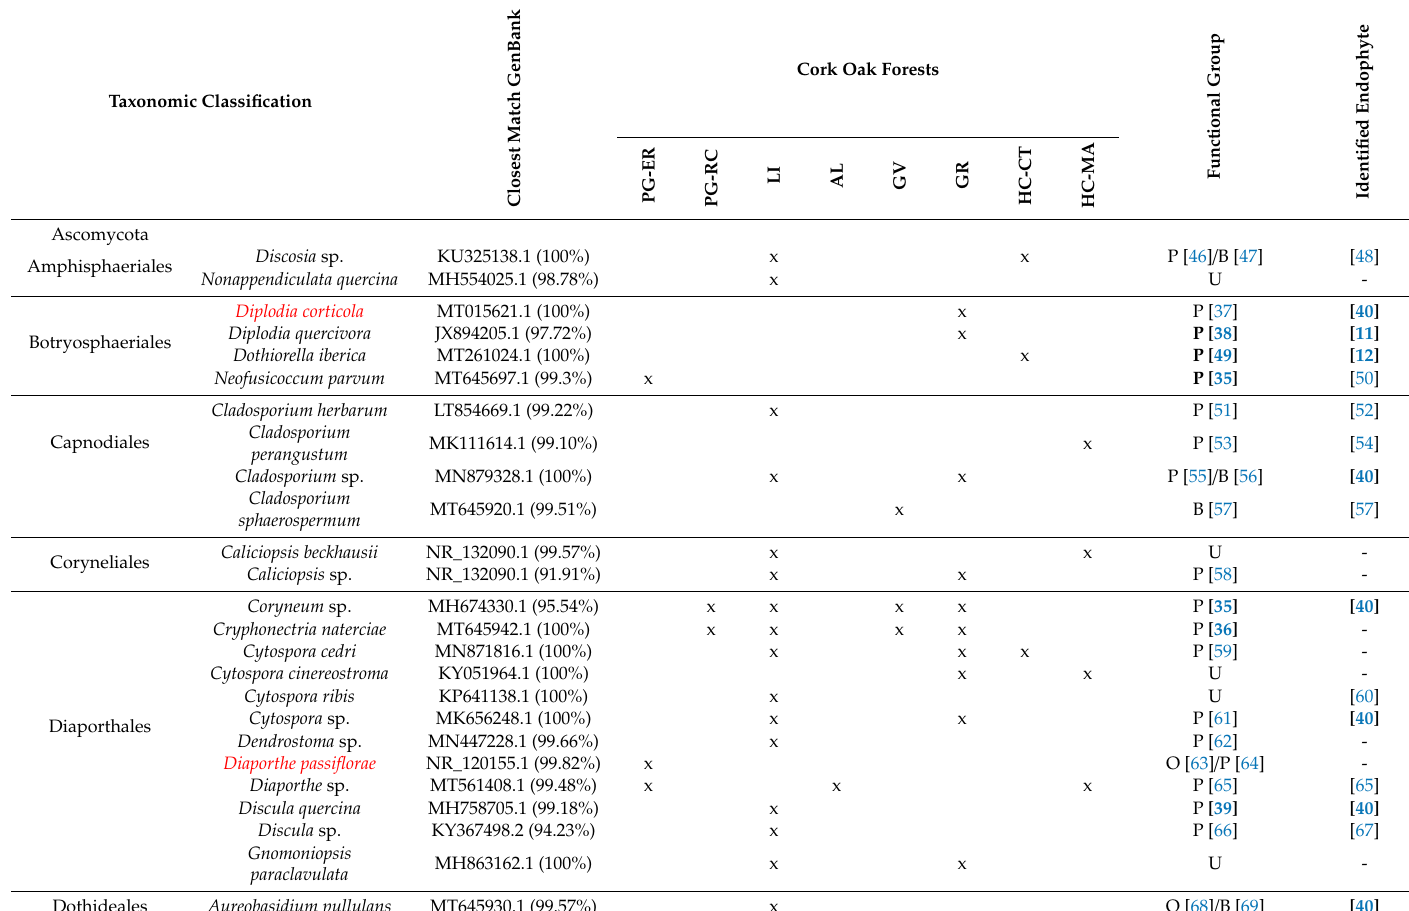
Table 2. Endophytic fungal OTUs recovered from twigs of cork oak trees located in di ff erent forests. Taxonomic classification (with closest match identity in brackets) and their respective functional group are revealed. Reports about their endophytic behavior are referred to. When existing, references related to cork oak are presented (bold). Isolates used in this work are depicted in red. Functional groups are represented as: P—pathogenic; B—beneficial; O—other;